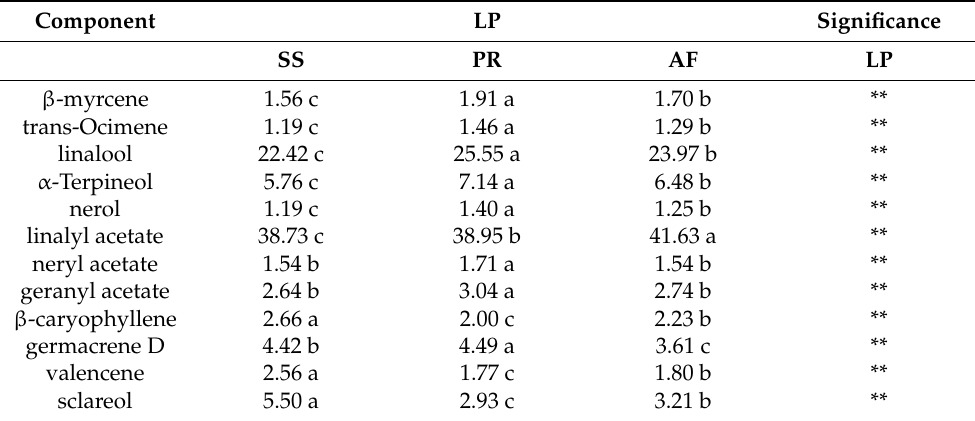
Local population code: PR = Prizzi; AF = Alcara Li Fusi; SS = S. Stefano Quisquina. ** = significant at p < 0.01; n.s. = not significant. Within the same row, means followed by the same letter are not significantly different for p ≤ 0.05 according to Tukey’s